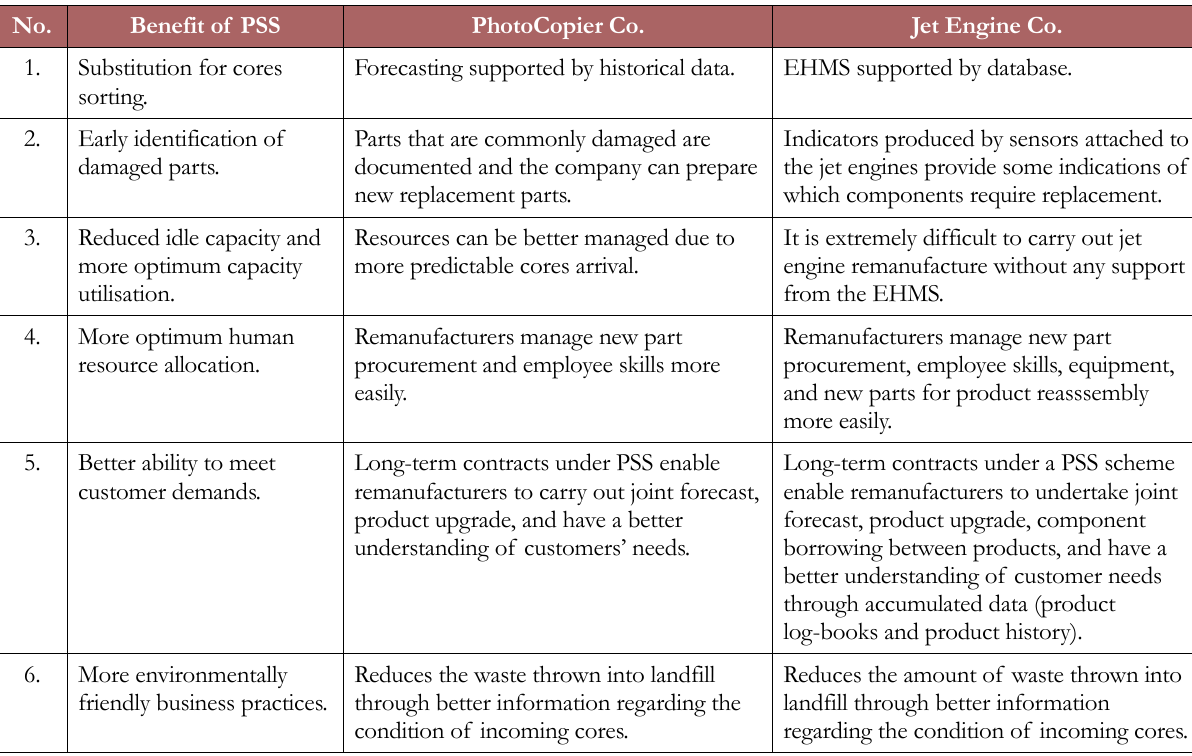
Table 3. Summary of the benefits of PSS for remanufacturing